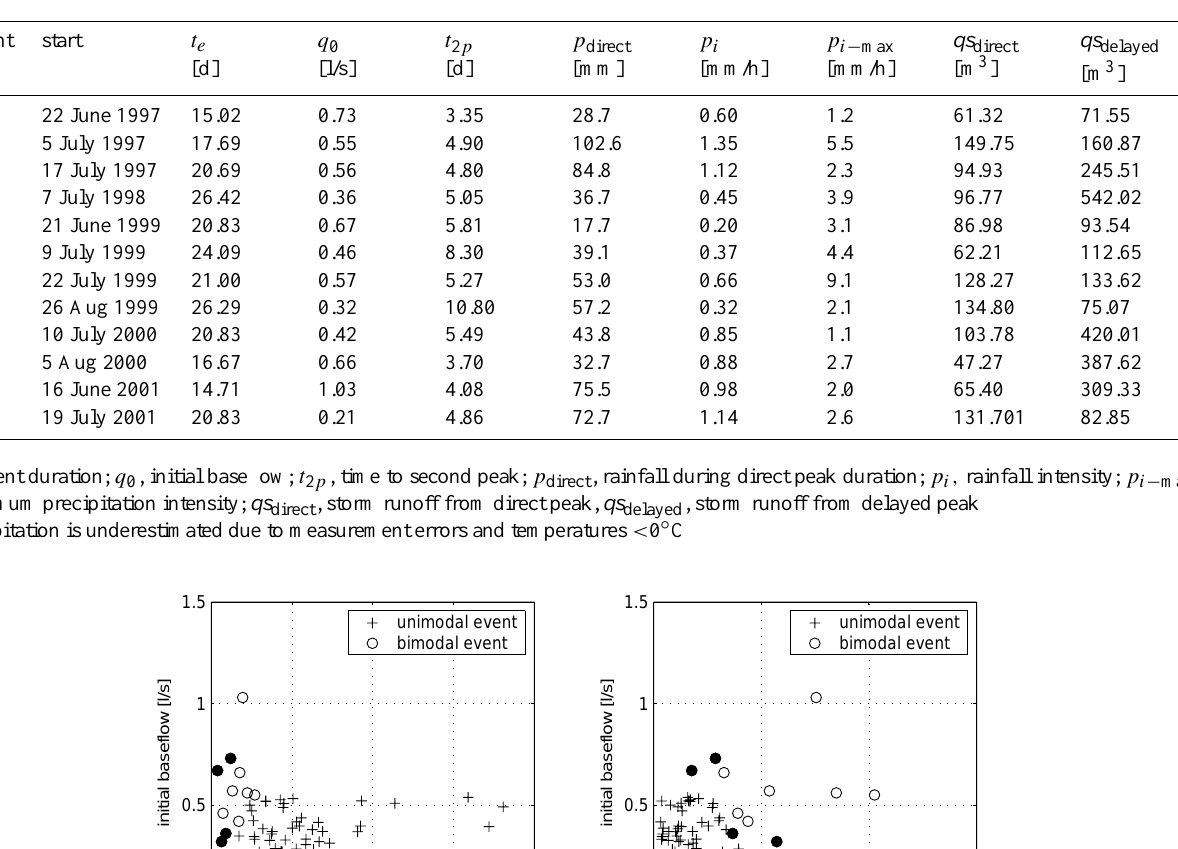
Table 4. Characteristics of the bimodal events measured at the headwater Limberg.